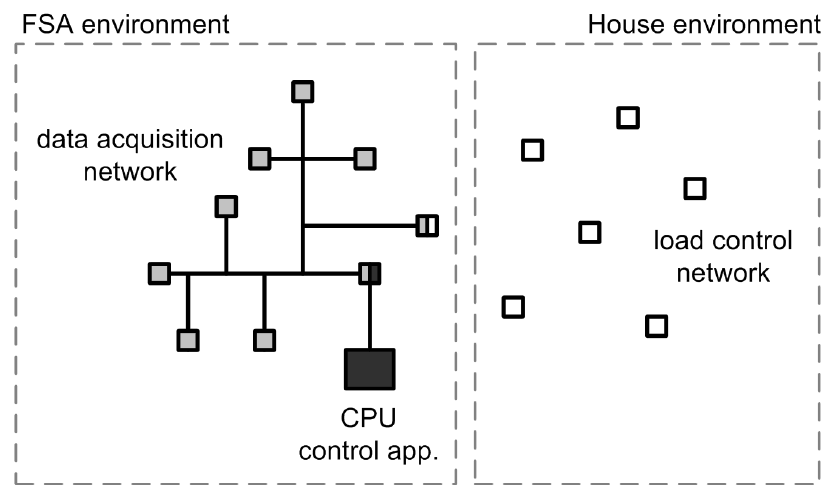
Data management system scheme. Grey boxes are data acquisition